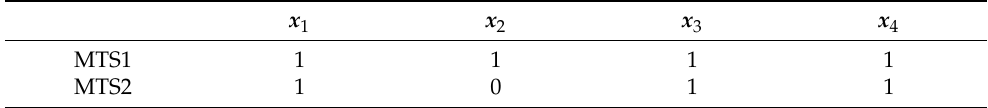
Table 4. Feature variable selection results of BT-MTS of of the balance data